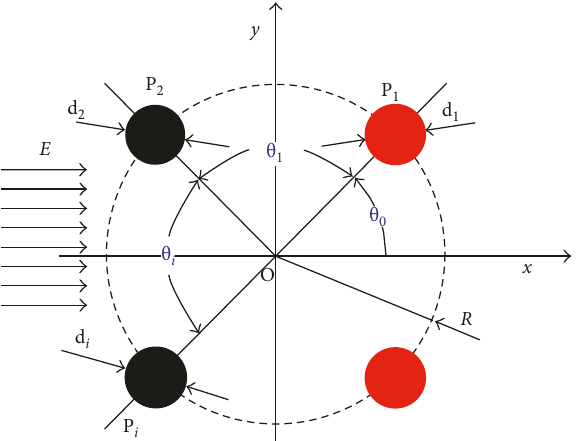
Figure 1: Cylindrical particles are equispaced on a circle in a two-dimensional DC uniform electric field E positive DEP and black represents negative DEP.